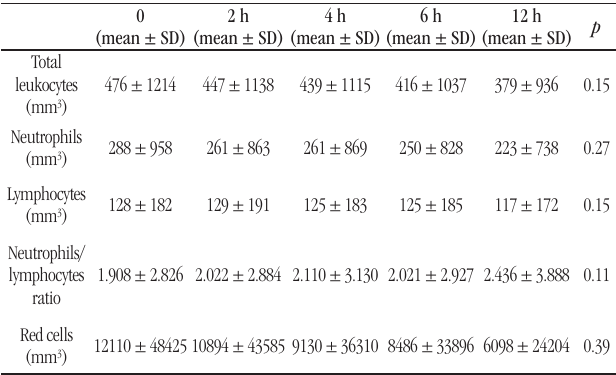
taBLE 2 − Total leukocytes, lymphocytes, neutrophils, red cells